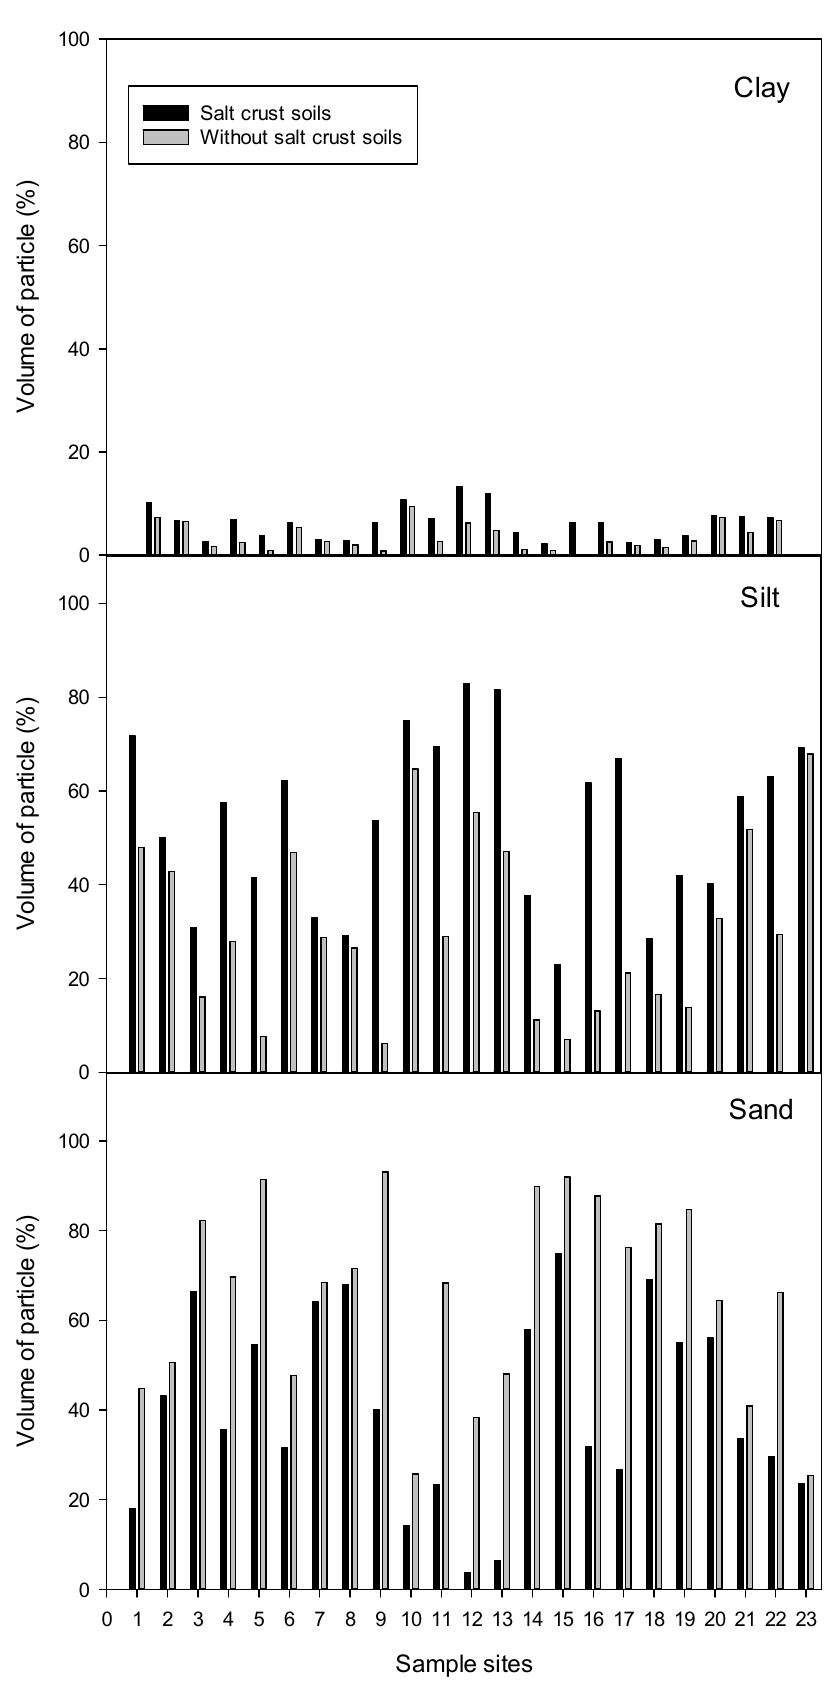
Figure 4. Clay, silt, and sand contents of soils with and without a salt crust at each sampling site.